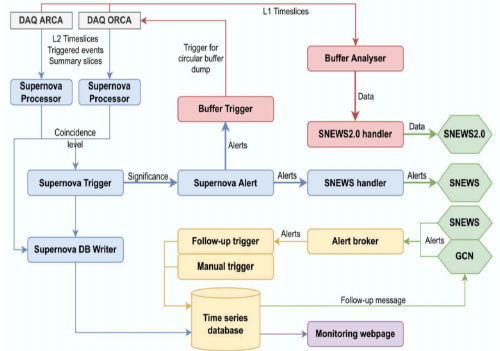
Figure 3. Monitoring the neutrino sky for the next Galactic CCSN with KM3NeT